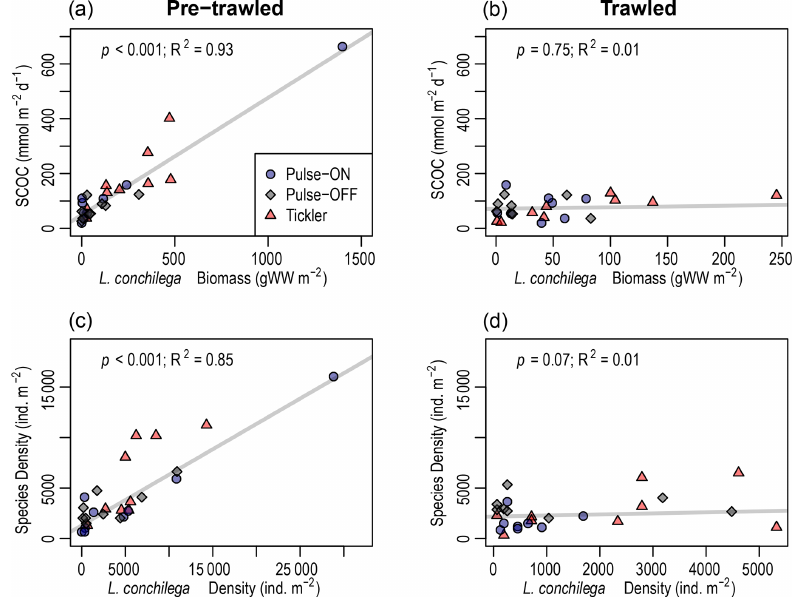
Figure 6. Robust regression analysis of sediment community oxygen consumption (SCOC; mmolm − 2 d − 1 ) versus Lanice conchilega biomass (grams of wet weight per square meter) (a, b) and densities of other taxa versus L. conchilega densities (individuals per square meter) (c, d) in pre-trawled and trawled sediments. Note x -axis scales are